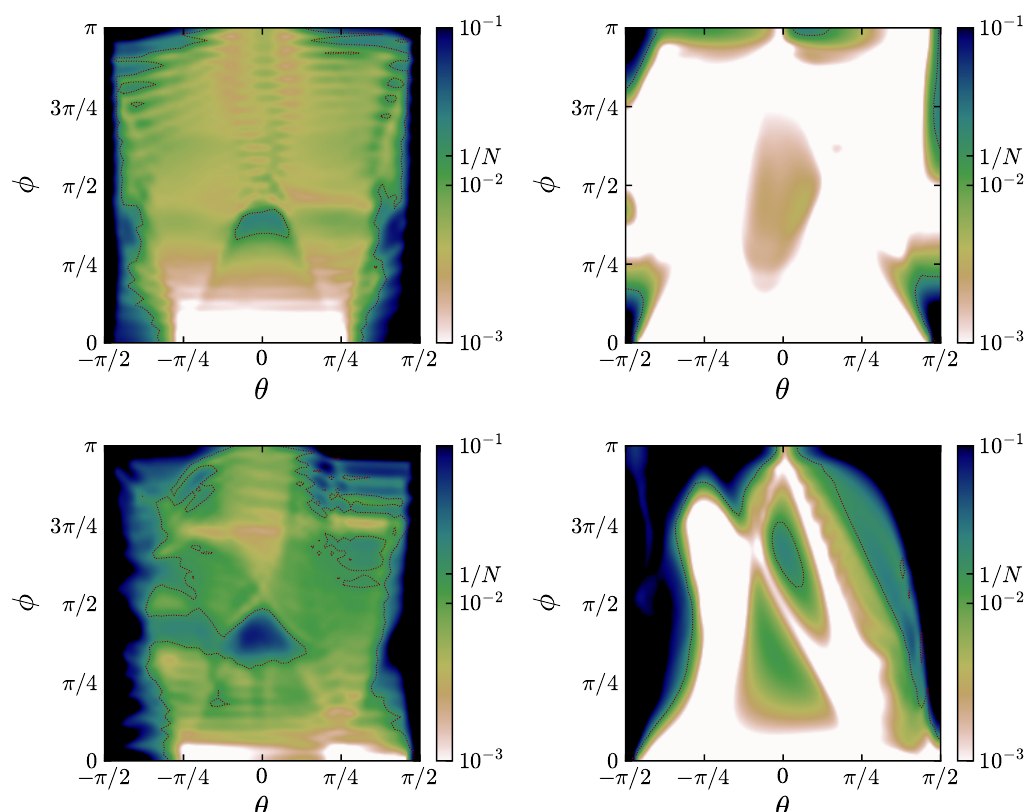
Figure 6: Probability of one particle to stay at the origin for different parameters ( θ , φ ) , in a logarithmic scale. The level 1 / N defines the frontier of the localized states ( N = 65). The interface separates a left region in a ‘0’ phase (first row) or ‘1’ phase (second row), and a right region, which is in phase − 1 for θ < π/ 4, 1 for θ > π/ 4, and 0 in between. The first column corresponds to an initial ‘0’ Bell state (symmetric), while the second column corresponds to a ‘3’ Bell state (antisymmetric). One observes (first row) the emergence of a localized region, induced by the interaction φ , for the ‘00‘ symmetric case that disappears for the antisymmetric ‘03’ case, for which almost all parameter space corresponds to delocalized states. A similar qualitative behavior is found for an interface with charge ‘1’ on the left (second row). be precise enough to detect a range of parameter values corresponding to localization at the origin. In Fig. 6 we fixed two values of the left rotation angle θ , and two initial states φ + L and ψ − , and varied the right angle θ and interaction phase φ . We plot P ( t ) as a function of ( θ , φ ) for the two Bell states, one symmetric and the other one antisymmetric (columns), and two types of interfaces, with charge zero or one on the left region (rows). Note the complex pattern of the localized-delocalized regions with the emergence of localization in areas of the parameter space, and their intricate boundary, especially in the case where the left region x < 0 possesses a c = 1 topological